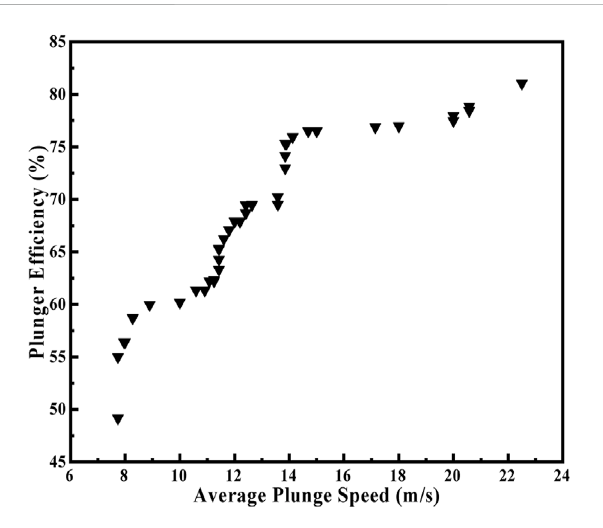
FIGURE 4 Change of plunger ef fi ciency with average plunger speed.